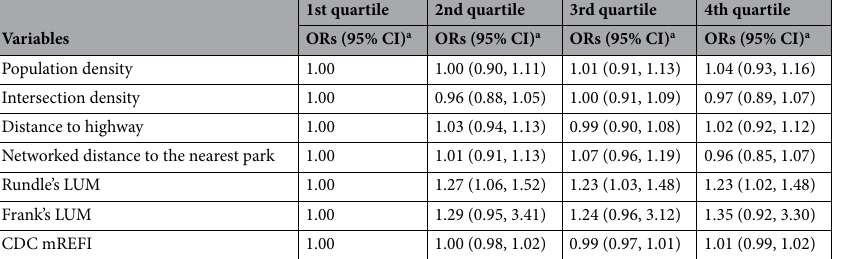
Table 4. Multinominal logistic regression to estimate the association between non-redundant built environment variables and telomere length. a Adjusted by age, sex, BMI, physical activity, health insurance, born place, acculturation, and census income.